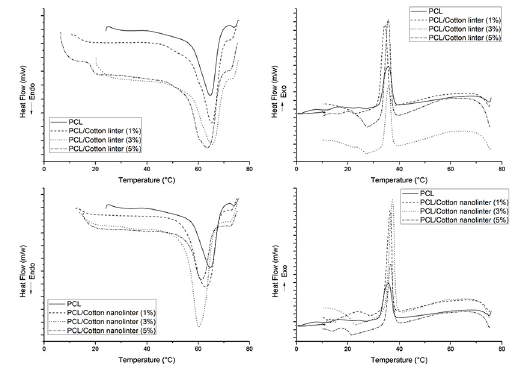
Figure 5: Melt endotherms and Crystallization exotherms for PCL/ cotton linter and PCL/cotton nanolinter compounds. Compositions indicated.